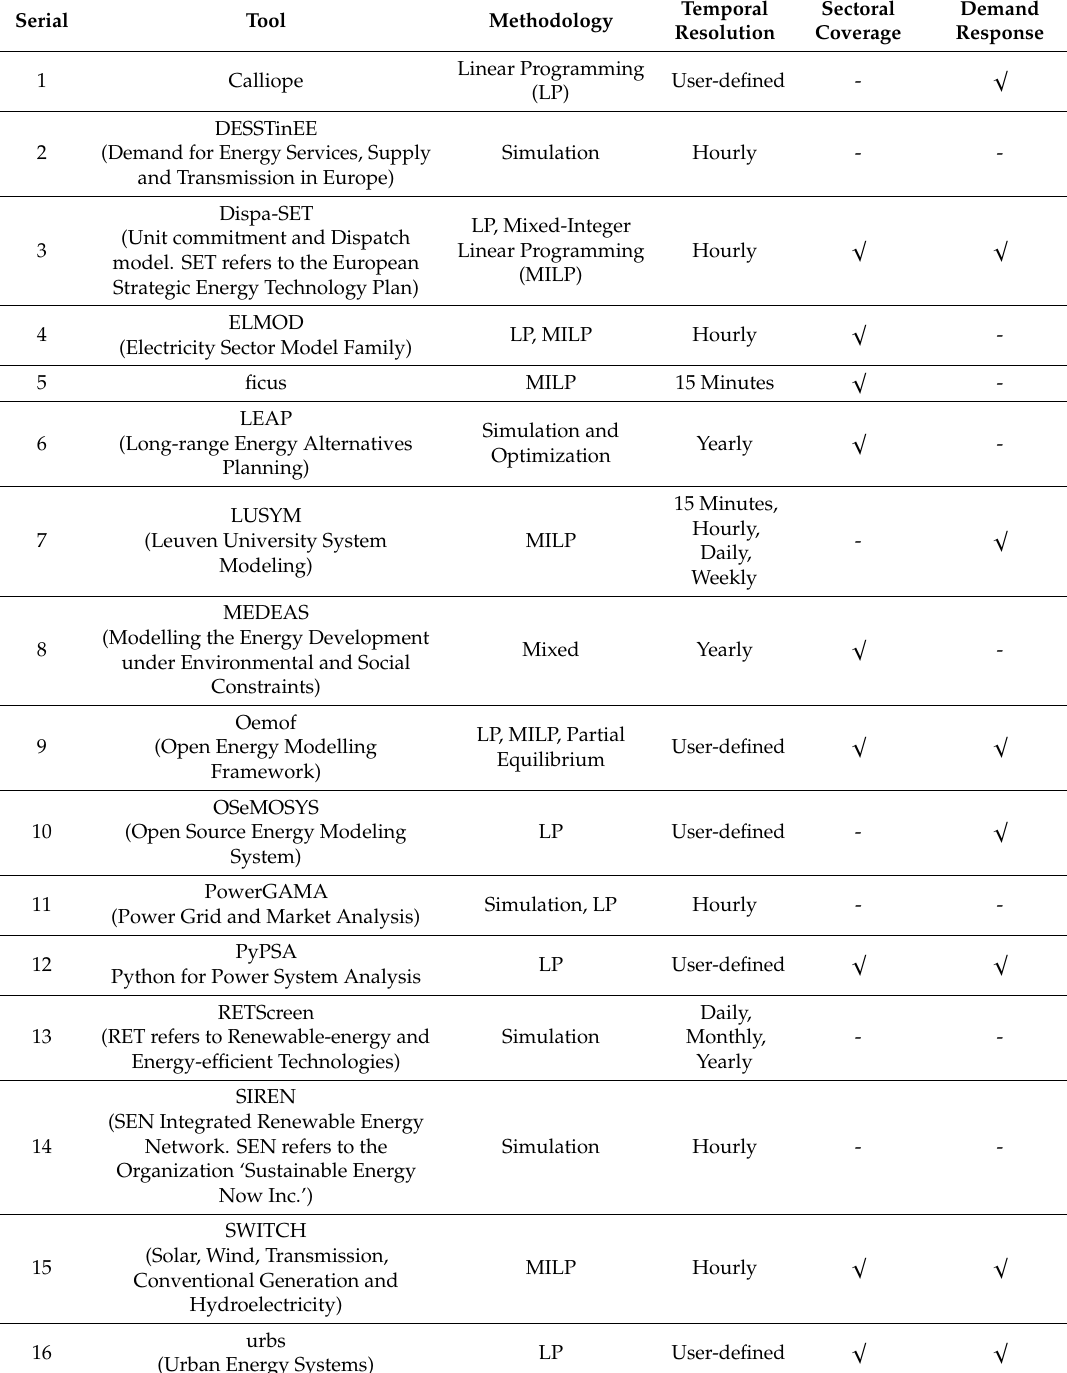
Table 1. Proposed tools based on specific rationales for modelling sector-coupled and RES-based Systems.